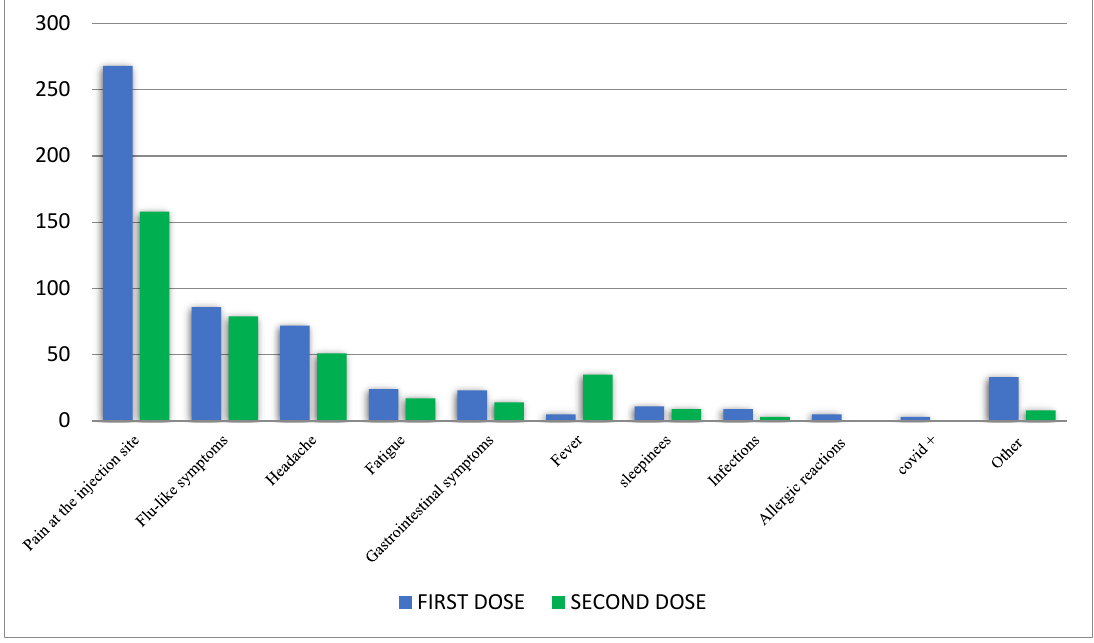
Figure 1. Distribution of Adverse Events Following Immunization (AEFIs) by Preferred Term (PT).